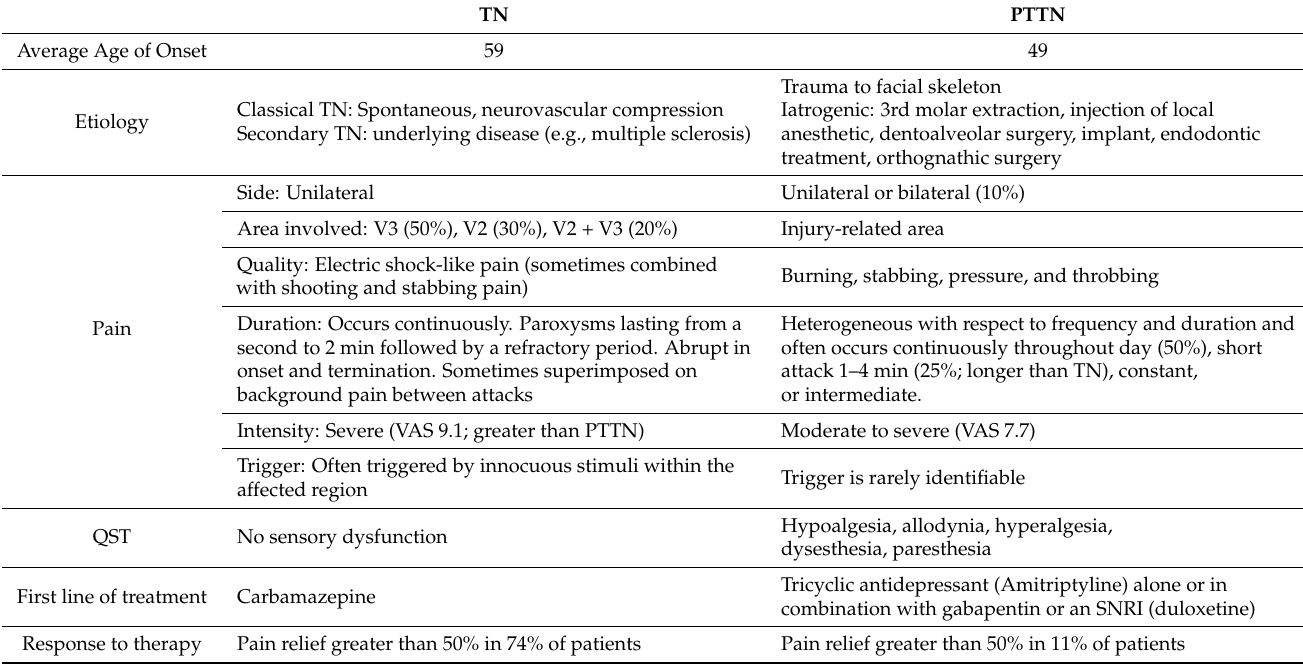
Table 2. Comparisons of the trigeminal neuralgia [8] and painful post-traumatic trigeminal neuropathy (PTTN). TN